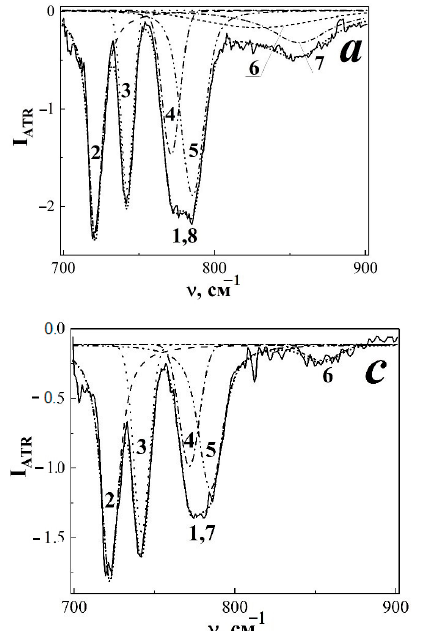
Figure 4. Fragment of the infrared spectrum of the disturbed total internal reflection of the initial ( a ) and irradiated with accelerated xenon ions to fluxes of 10 8 and 10 11 cm − 2 thermoradiationally modi- fied polytetrafluoroethylene ( b , c , respectively) in the spectral range of 700–900 cm − 1 . 1 Experimental data; 2–6 ( a – c ), 7 ( b , c ), maxima of approximating Voigt random functions; 7 ( b , c ), 8 ( a , b ) approxi- mation